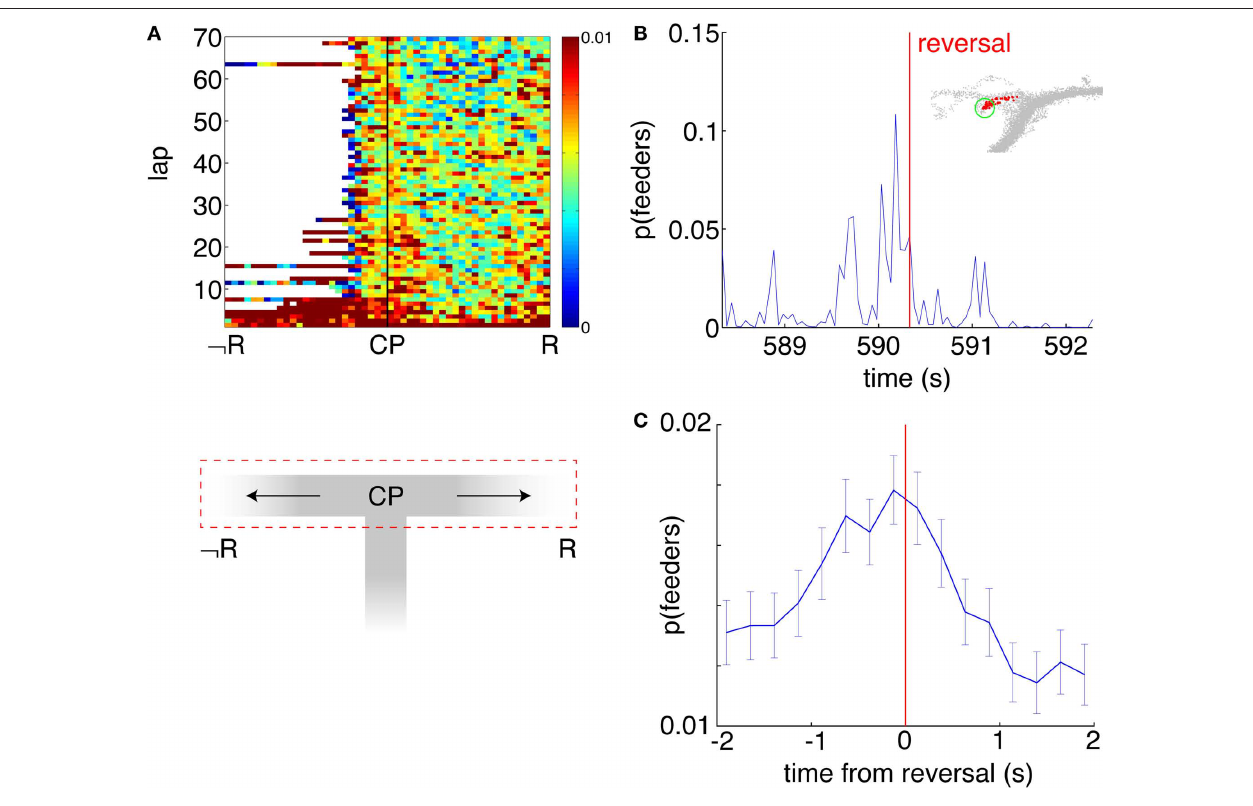
(R). Strong feeder representation on the non-rewarded side arises from a more general increase associated with reversals (B,C) . (B) Example of p(Feeders) over time around a reversal point (inset, green circle) indicated by the vertical red line. Averaged over all reversal points, p(Feeders) is increased around the reversal point, higher before than after [ F = 44.87, p < 10 − 6 , (C) ]. Errorbars are